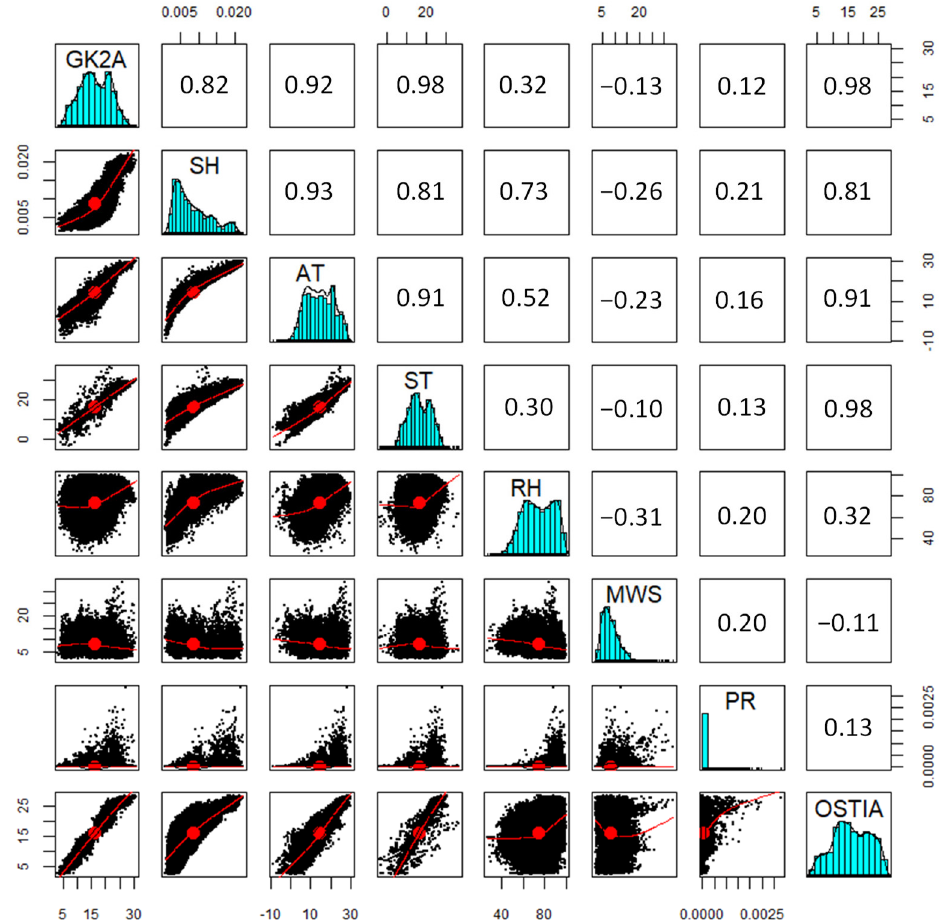
Figure 6. Correlation matrix between variables: bivariate scatter plots below the diagonal, histograms on the diagonal, and the Pearson correlation coefficients above the diagonal. In bivariate scatter plots, the x -axis refers to the variable located at the top of the matrix, and the y -axis refers to the variable located to the right of the matrix (GK2A = GK2A SST ( ◦ C), SH = Specific humidity (kg/kg), AT = Air temperature ( ◦ C), ST = Skin temperature ( ◦ C), RH = Relative humidity (%), MWS = Maximum